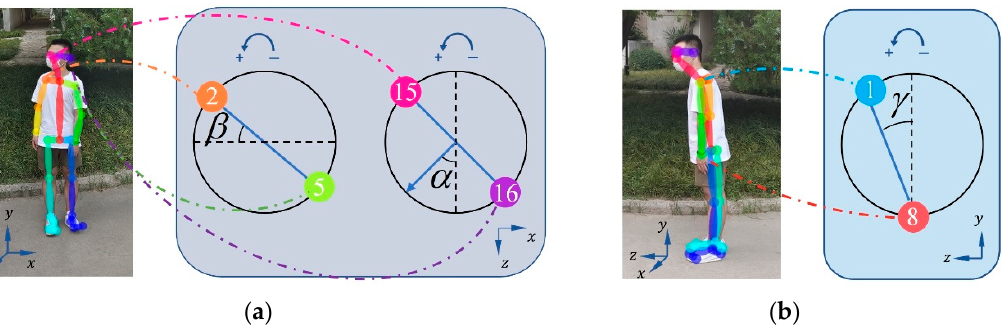
Figure 4. Schematic diagram of pedestrian head turning angle, shoulder turning angle, and torso forward tilt angle. ( a ) Projection diagrams of points 2 and 5 and points 15 and 16 in the XOZ plane when the pedestrian turns their head and shoulders between turns, respectively, and ( b ) shows the projection diagrams of points 1 and 8 in the YOZ plane when the pedestrian torso tilts forward; “1” indicates the neck point, “8” indicates the midpoint of the left hip and right hip line, “2” indicates the right shoulder point, “5” denotes the left shoulder point, “15” denotes the right eye point, and “16” denotes the left eye point. We set the pedestrian’s forward tilting direction as the Z-axis, the direction of the pedestrian height as the Y-axis, and the direction of the pedestrian parallel to the camera lens as the X-axis. The head and shoulders turning to the left was defined as the positive direction.